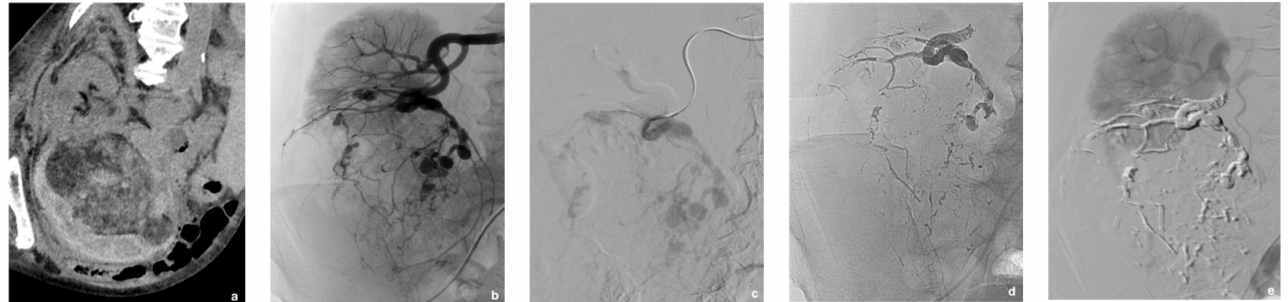
Figure 2. A 77-year-old patient hospitalized for right acute flank pain, hematuria and deglobulisation. ( a ) Unenhanced com- puted tomography (CT) scan revealed right perirenal hematoma caused by a large right lower pole renal angiomyolipoma (rAML). ( b ) Embolization to stop bleeding was performed urgently. Selective injection of a lower unique branch of the right renal artery showed hypervascularization of rAML with neovascularization and aneurysms. ( c , d ) Selective embolization of rAML with a mixture of 1:6 cyanoacrylate glue and lipiodol was performed allowing both distal and proximal embolization of the feeding artery and aneurysms with the same embolic agent. ( e ) Post-procedure angiogram showed total exclusion of rAML with good preservation of viable renal